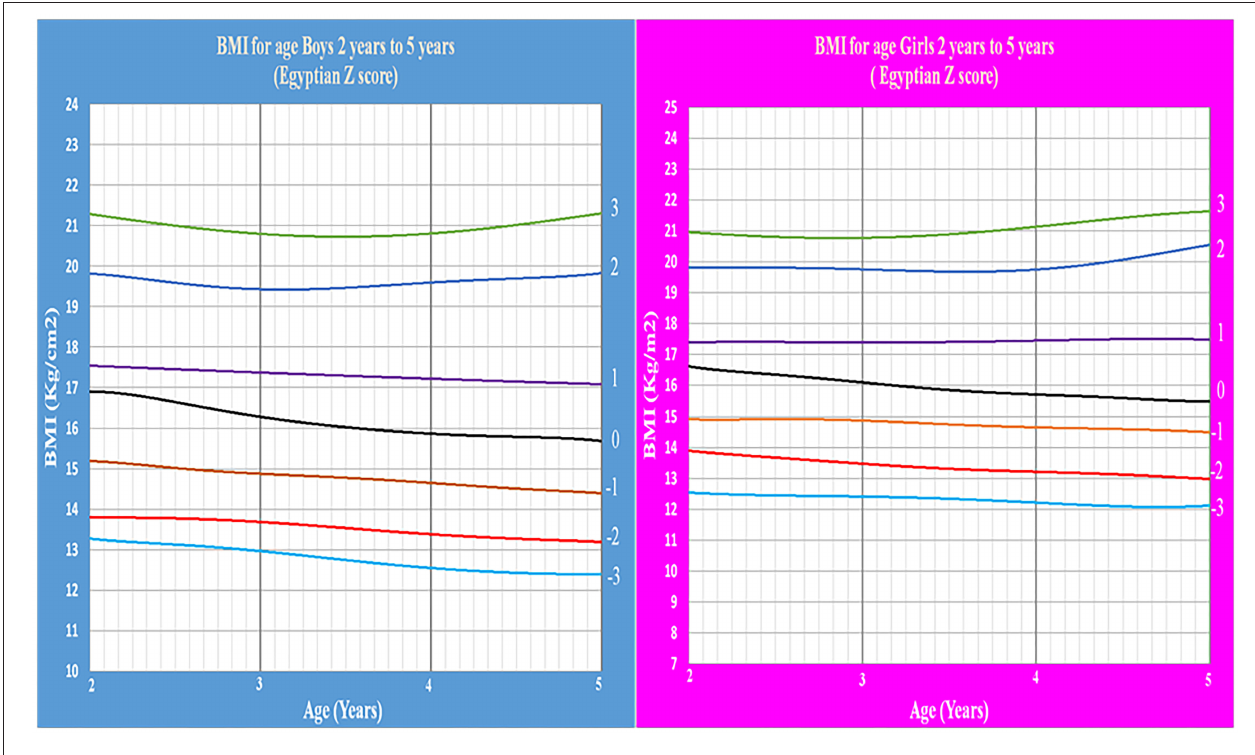
FIGURE 7 | Egyptian Z score BMI for age from 2 to 5 years for boys & girls.